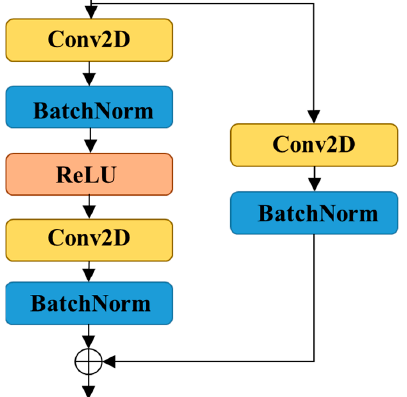
Figure 3. Illustration of the residual module.